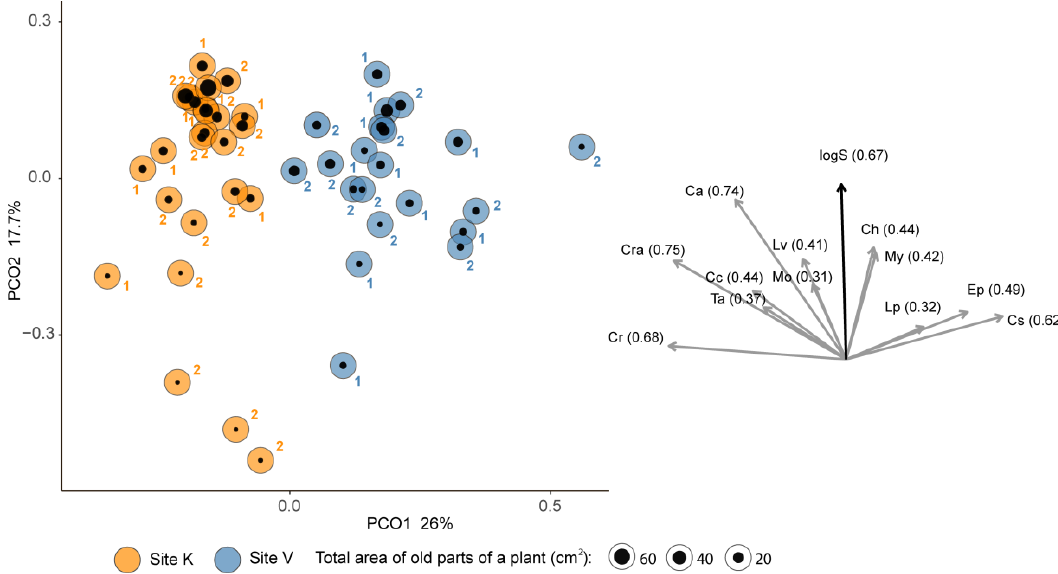
Figure 4. Principal coordinates ordination (PCO) of sessile species percent covers on old parts of Phycodrys rubens in September 2015. Bray-Curtis similarity on fourth root transformed data. Labels (1 or 2) indicate the replicate frame number. Species with R 2 (in brackets) > 0.2: Mo— Molgula sp. (Ascidiacea); My—juvenile Mytilidae ( Musculus discors and Modiolus modiolus ) (Bivalvia); Cc—